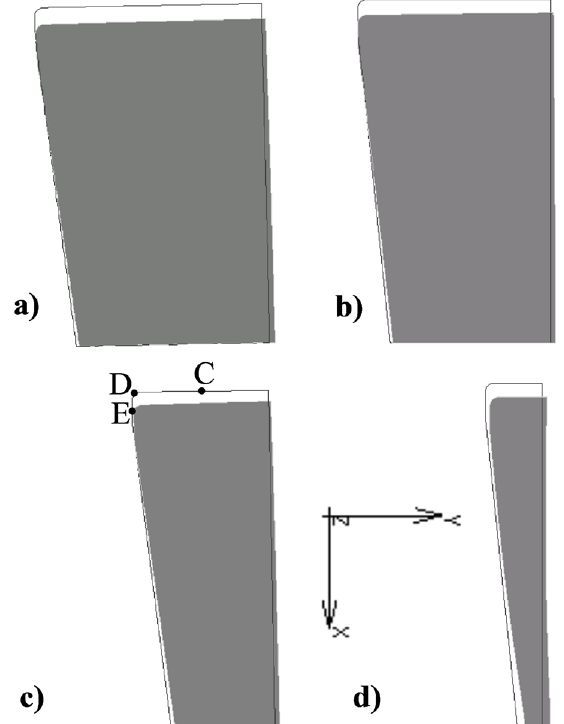
Figure 8. Die deformation during extrusion: ( a ) R = 11, ( b ) R = 7, ( c ) R = 3, ( d ) R = 1.5 [(def. factor × 50) C, D and E—measuring points of displacement Ux and Uy in all models]. Due to the different die deformations depending on the R ratio, displacement of the selected die points (Figure 8c) in the axial Ux (points D and C) and radial Uy (points D and E) were analyzed.